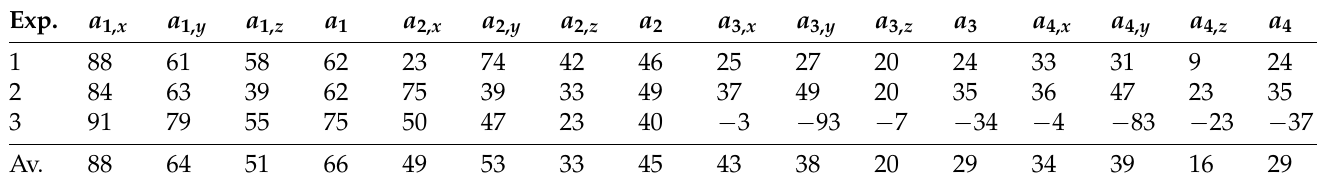
Table 7. ET amplitude reduction rates during the Prototype (A) Open-Loop evaluation.